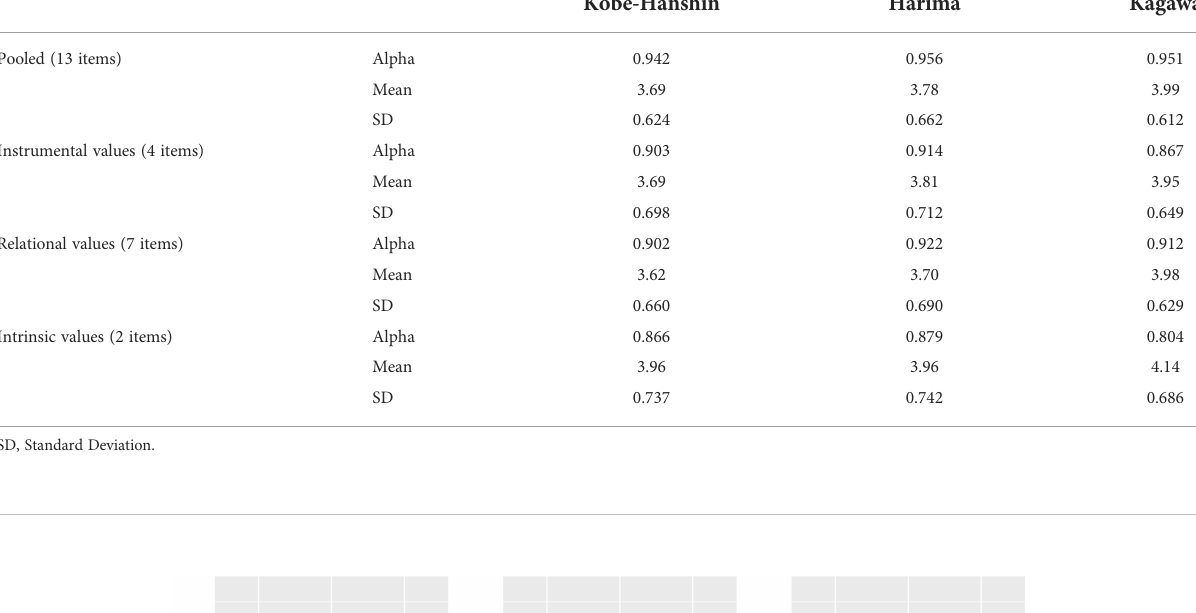
TABLE 5 Cronbach ’ s alpha, mean, and SD by value class and SES.